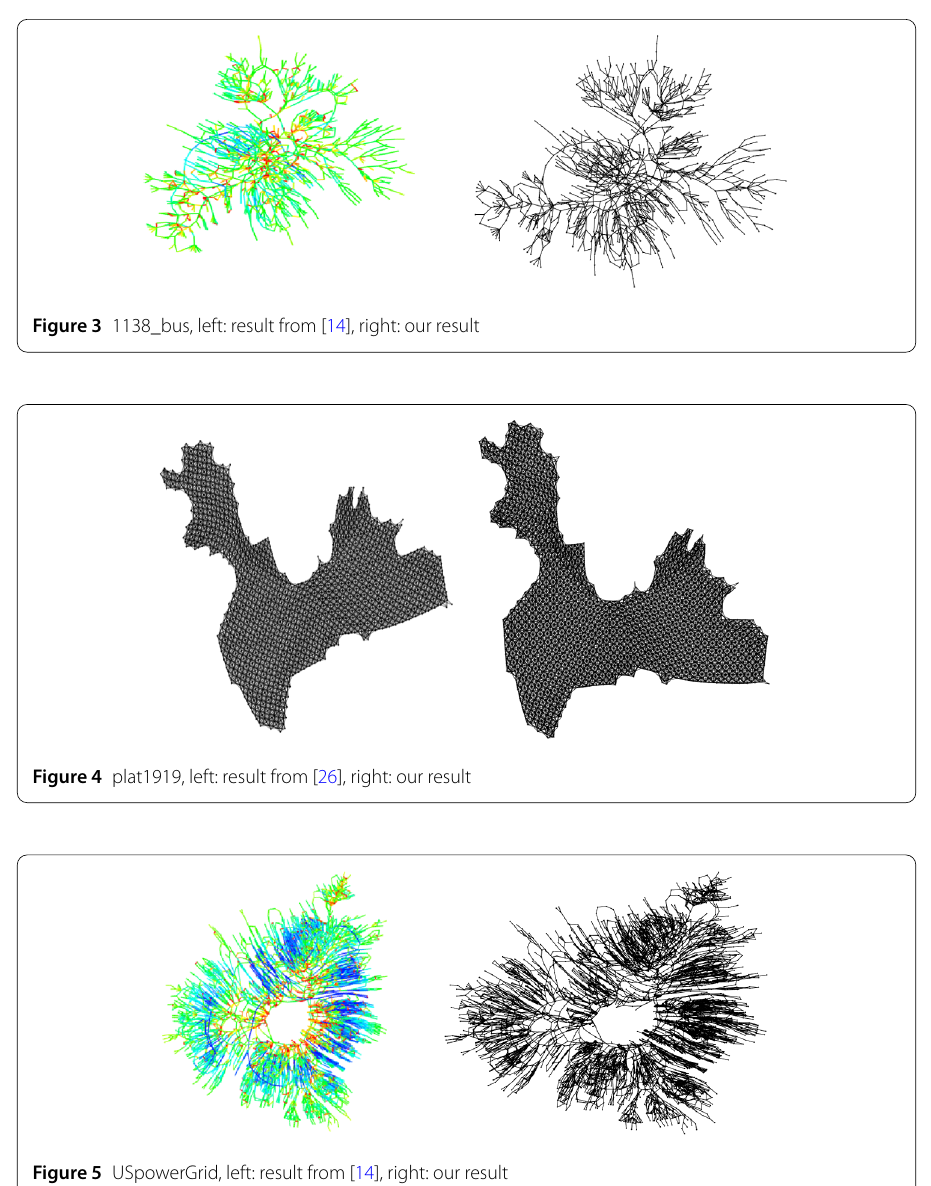
wards, only small changes occur. After 47 iterations with 35 accepted SOR values, one of the stop criteria is fulfilled, and the algorithm